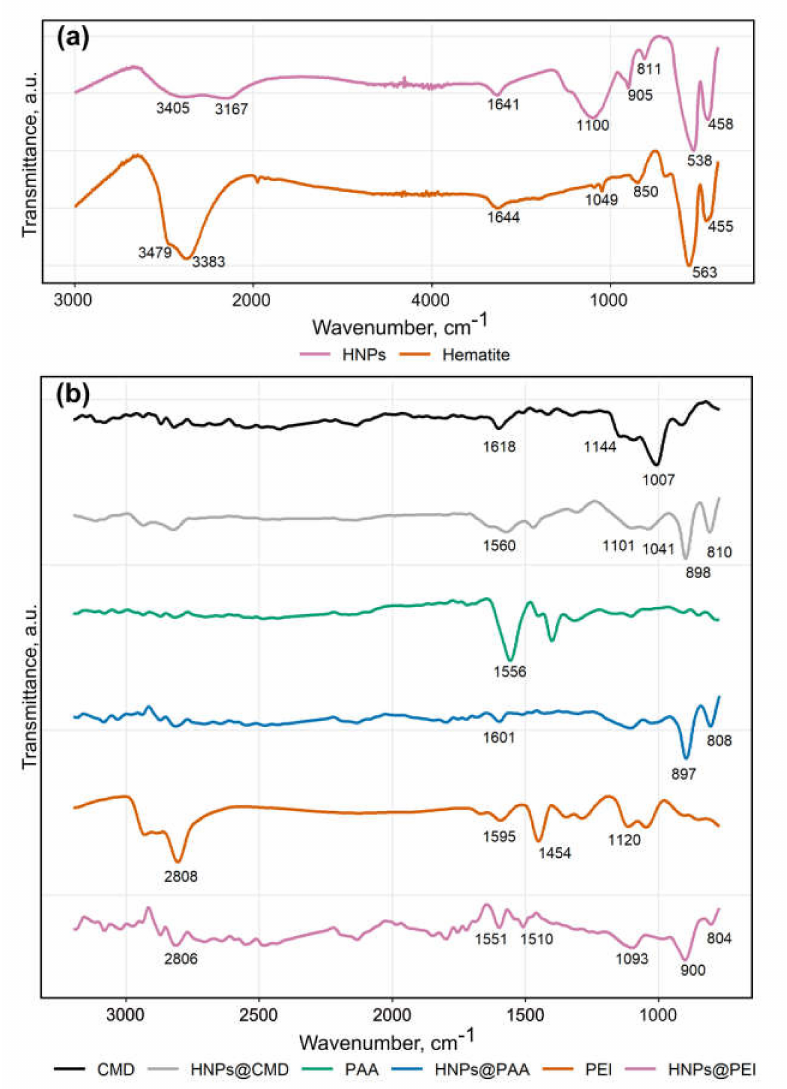
Figure 3. Attenuated total reflectance (ATR) infrared spectroscopy (FTIR) spectra. ( a ) Comparison of the hematite nanoparticles (HNPs) spectrum with the standard hematite sample; ( b ) Spectra of polymer-coated HNPs in 770–3200 cm − 1 range in comparison with the spectra of pure